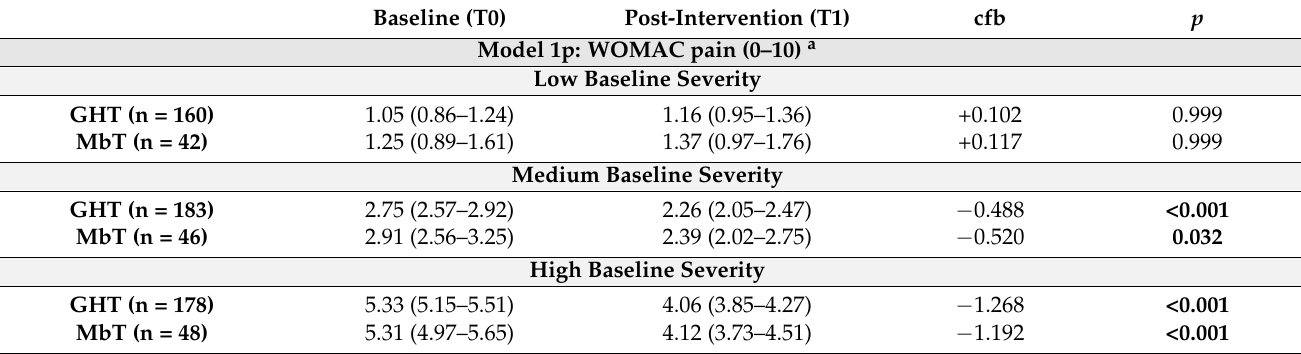
Table 5. Estimated marginal means (95% CI) from the LMMs and within-group change from base- line